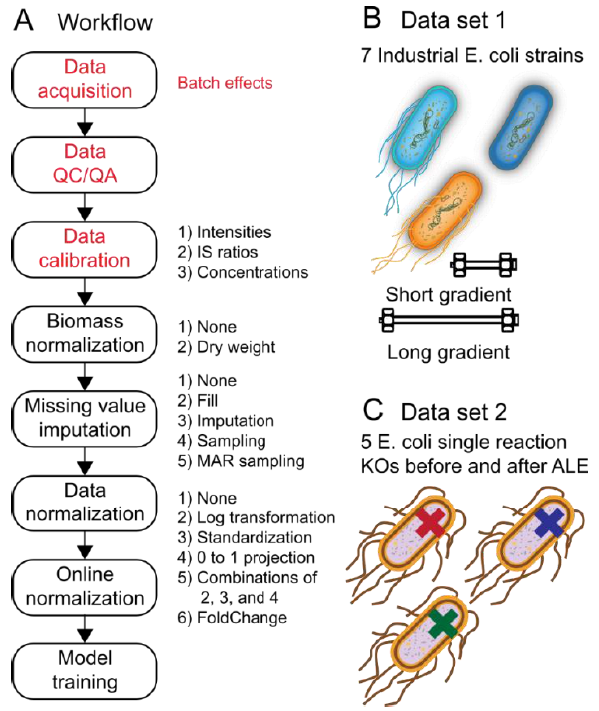
Figure 1. Data preprocessing workflow for metabolomics. ( A ) Workflow overview. Red lettering in the workflow diagram indicates steps that lead to so-called “Batch effects” between metabolomics runs. Black lettering to the right of each workflow box indicates preprocessing options that were explored in this study for the corresponding data preprocessing workflow steps. ( B , C ). Datasets 1 and 2 used for the classification task (see Methods section 3.1). ( B ). The dataset included 7 different strains of E. coli where the task was to predict the correct strain from metabolite levels. Importantly, the data were run twice (once on two different instruments) resulting in batch effects between the two runs. ( C ). The dataset included 5 different single-knockout (KO) strains of E. coli where the task was to predict the correct knockout from metabolite levels.